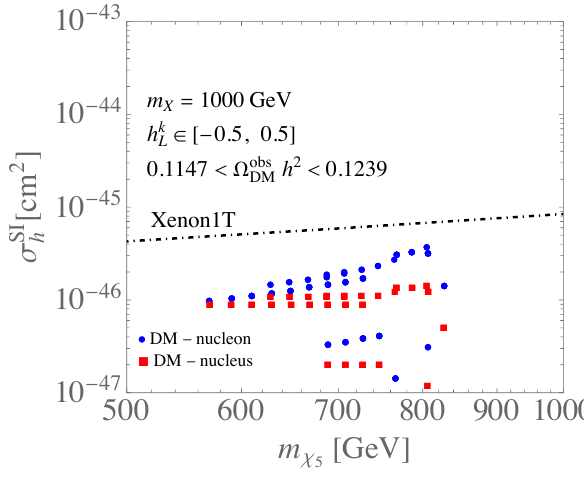
Figure 5 . Scatters for σ SI as a function of m χ , where the constraint from Ω obs h 2 is applied, DM h 5 and the current upper bounds for the SI DM-nucleon scatterings is taken from the XENON1T experiments in [48]. The dotted points are obtained from eq. (3.4), and the squares are obtained though DM-nucleus scattering calculated by using DMFormfactor